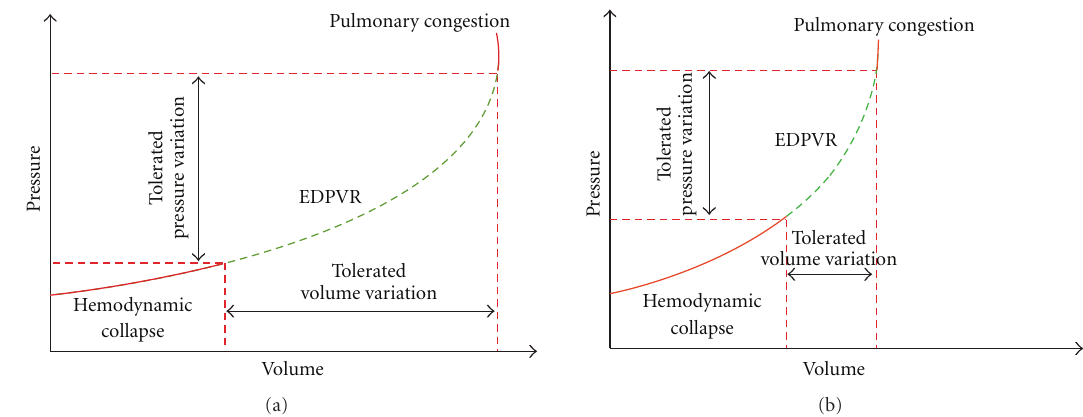
Figure 1: Schematic representation of the end-diastolic pressure-volume relationship (EDPVR) in the absence (a) or presence (b) of diastolic dysfunction. The dashed segment of the EDPVR represents the pressure-volume interval in which an individual remains hemodynamically stable. In (b), the steeper EDPVR narrows the ventricular pressure-volume interval and increases the individual’s susceptibility to hemodynamic